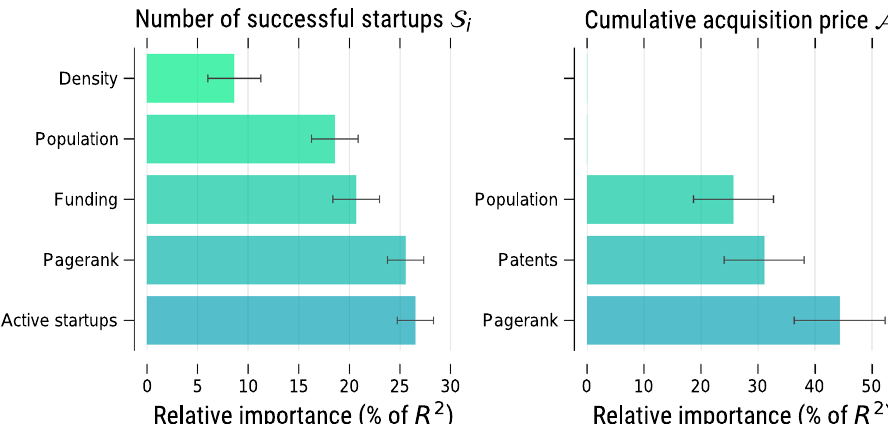
Fig. 5 Relative contribution of each variable to the total variance explained by the regression models in Table R. The relative contribution is expressed as percentage of the R 2 determined by each